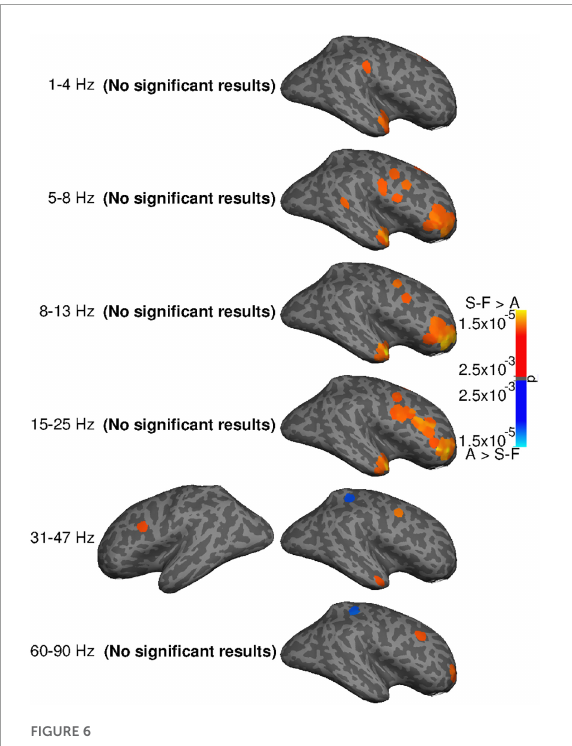
FIGURE6 Systematic group-level differences (two-sided t -test, p ≤ 0.005, uncorrected) in power reduction by SOBI-FastICA and AMICA. P -values illustrated. The “(no significant results)” texts indicate that no significant results were found on the given hemisphere on the given frequency band. Orange indicates areas where the SOBI-FastICA pipeline reduced more power, and blue areas where AMICA reduced more